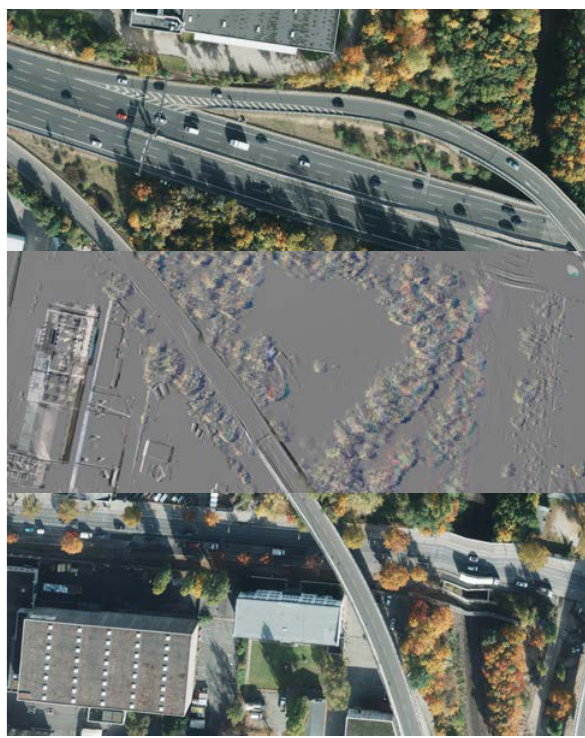
Fig. 6 Geometric quality by DOP difference in overlapping zones.